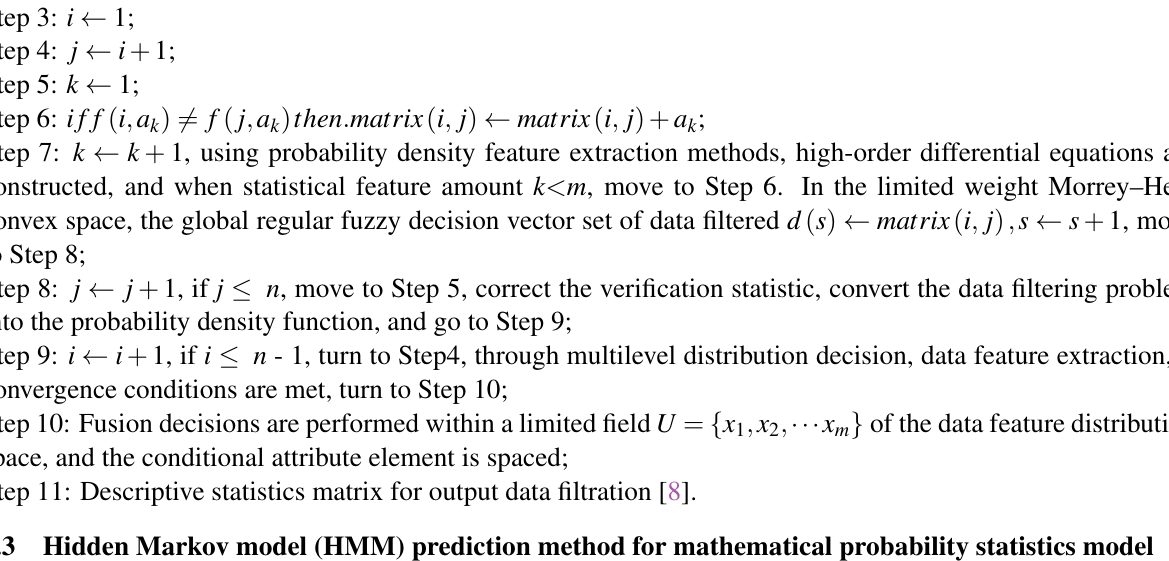
Fig. 1 Overall design of the probability mathematical model of data